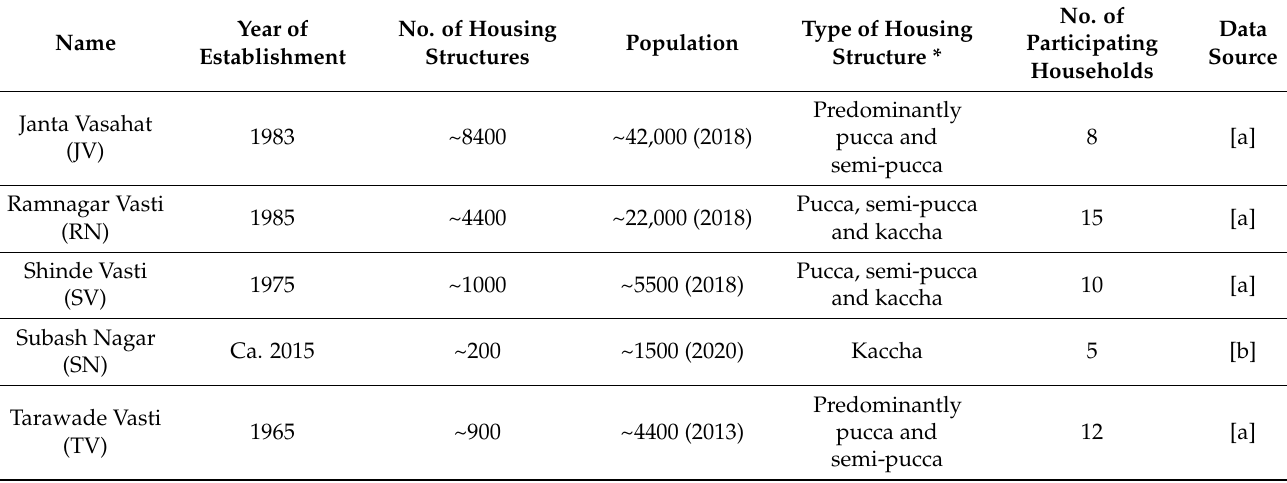
Table 1. Overview of sampled informal settlements.